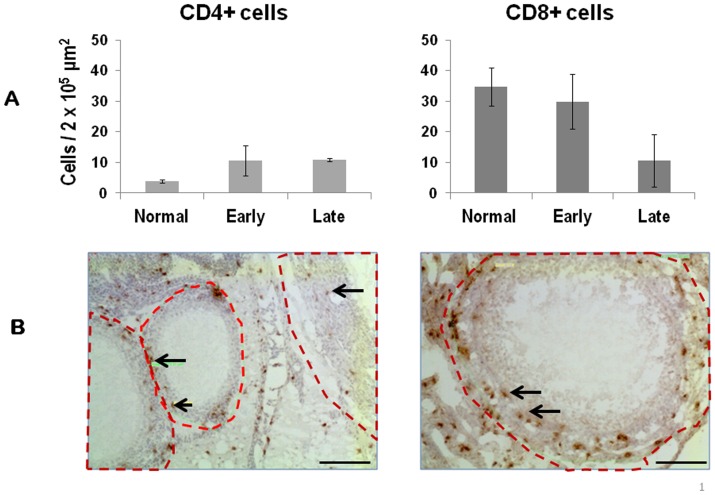
Comparison of the number of immune cells in ovarian follicles determined by morphometric analysis.(A) B (Bu1a+) cells were rarely found in follicles and therefore were not counted. The number of CD4+ T cells increased slightly (p = 0.052) and the number of CD8+ T cells decreased (p = 0.009) in late stage ovarian tumors compared to normal ovaries. At each stage there were more CD8+ compared to CD4+ T cells (normal ovary, p = 0.003; early stage tumor, p = 0.008; late stage tumor, p = 0.007). Follicles were defined as shown in (B) and cells within the designated area were counted and the average determined per 2×105 µm2 area of follicle. Three sections from each ovary for each hen were counted at a magnification of 20x; scale bar = 50 µm. Error bars represent mean ± SEM.